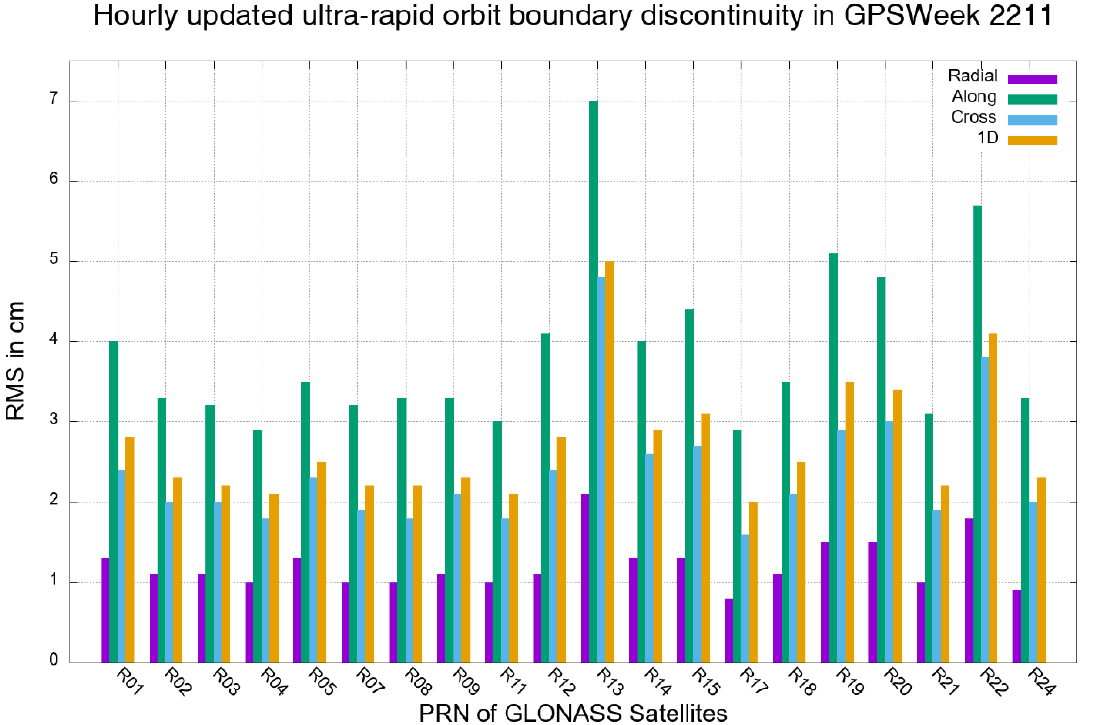
Figure 17. Mean RMS of overlapping in the RAC components and 1-D of GLONASS satellites.